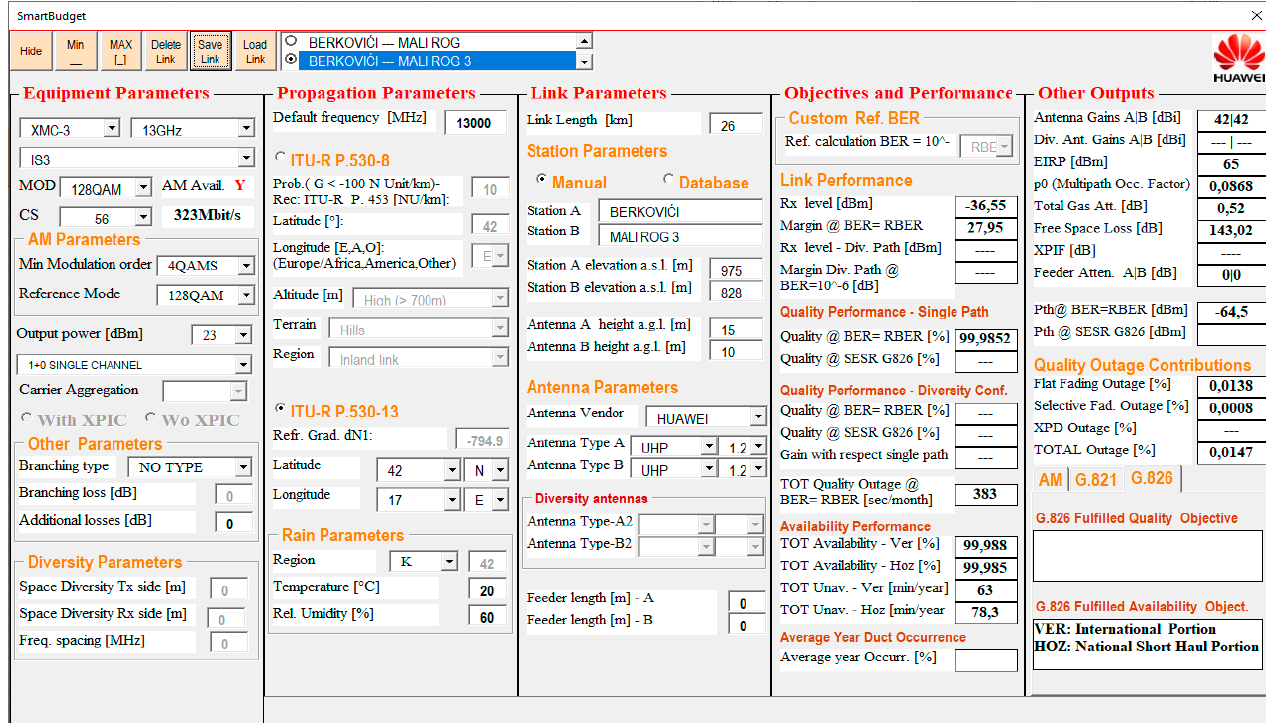
Figure 12. Prediction for the second RR section; 128 QAM, 323 Mb/s.